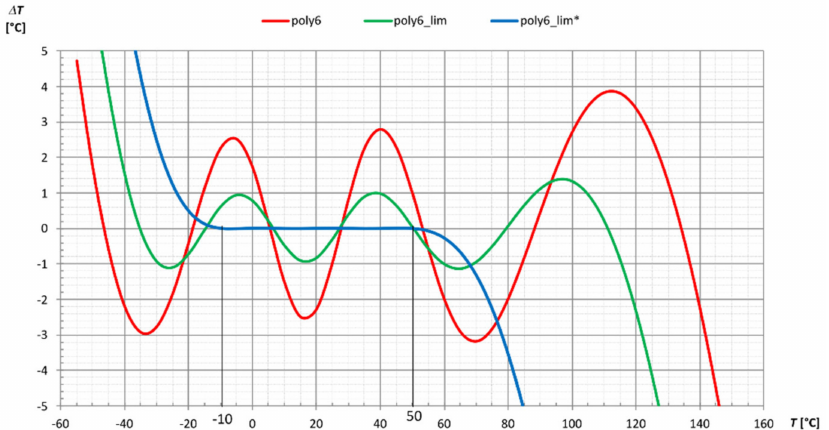
Figure 11. Temperature error for 6th-order polynomial approximation—fitted across different tem- perature ranges: nominal and limited (poly6_lim,